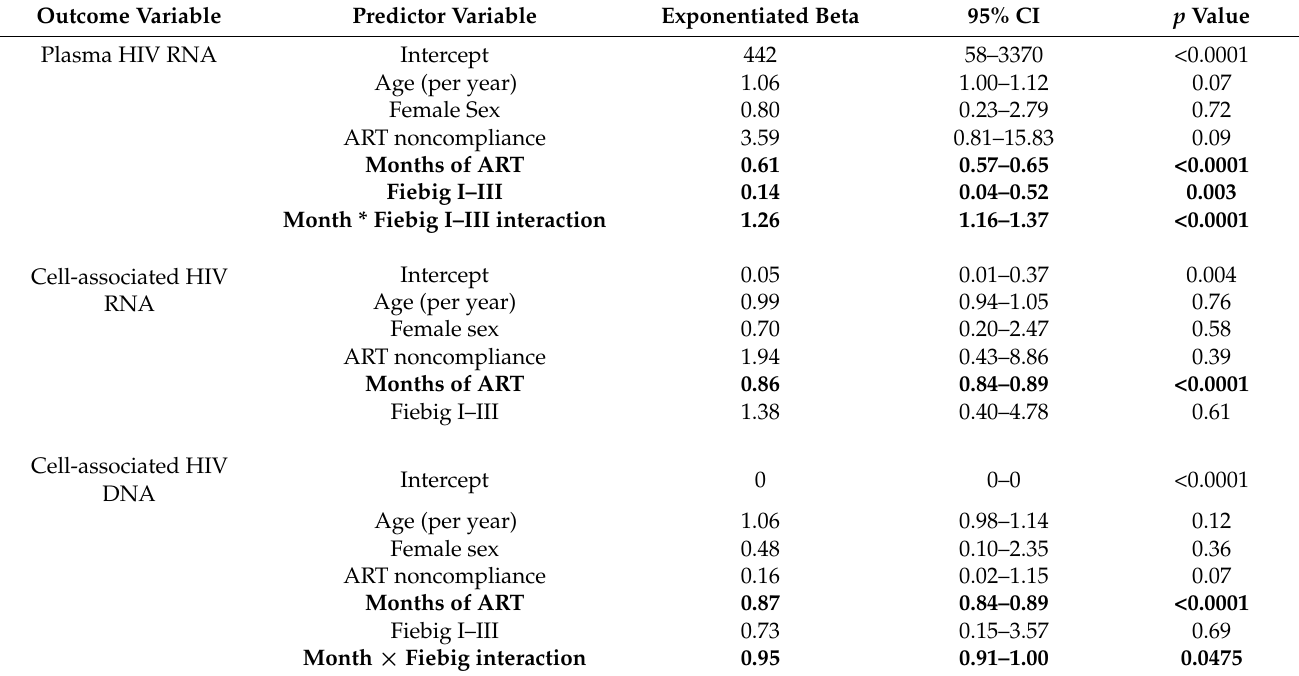
Table 2. Multivariable negative binomial modeling of three reservoir analytes. Reference categories are Fiebig IV–VI, zero months of ART, full compliance with antiretroviral therapy, and male sex. Significant associations are in BOLD